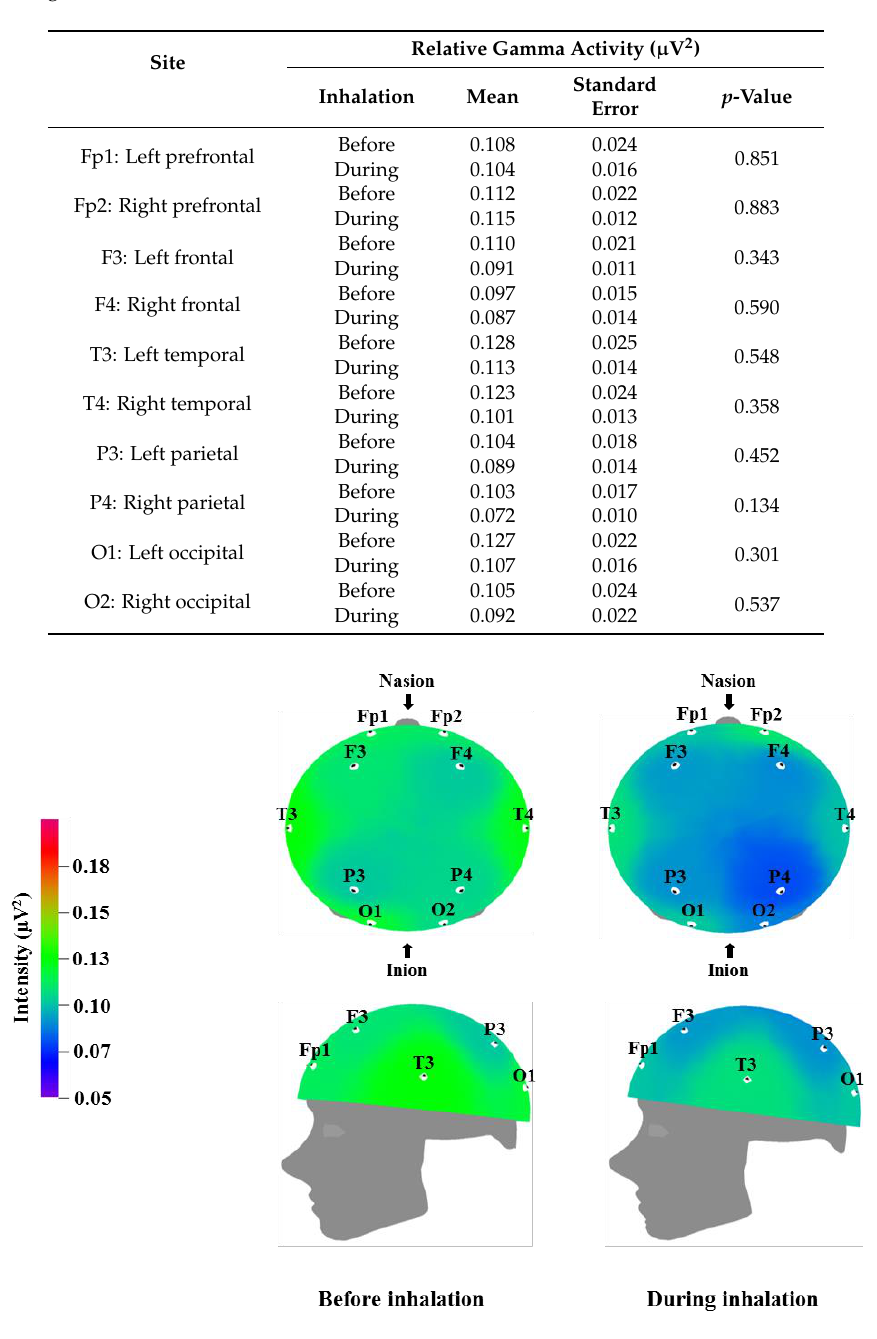
Table 6. Effect of inhalation of volatile organic chemicals (VOCs) from Chrysanthemum indicum Linn é on relative gamma wave.